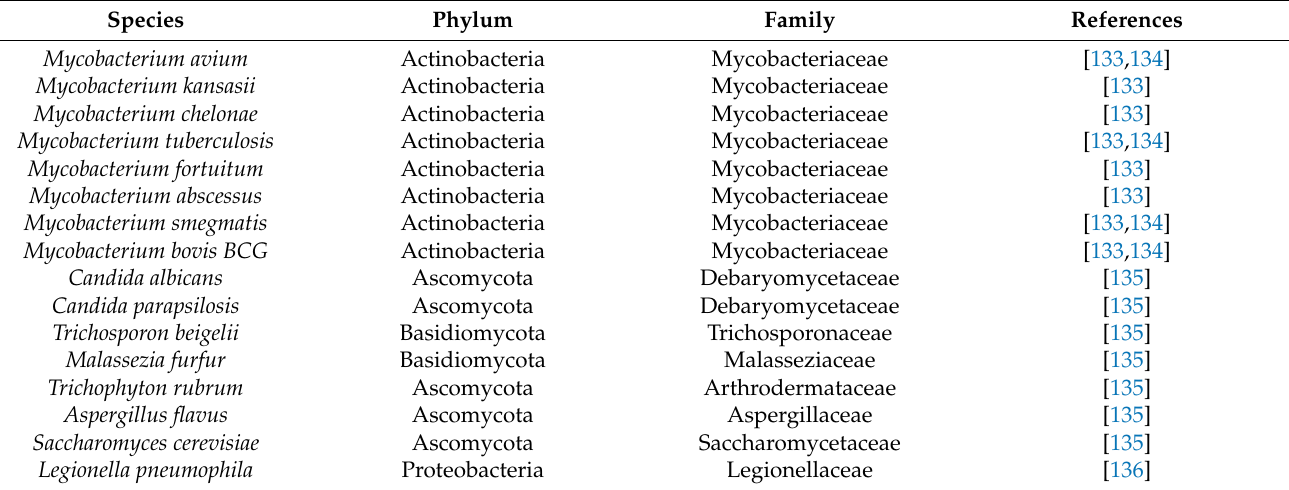
Table 2. Bacteria and fungi sensitive to